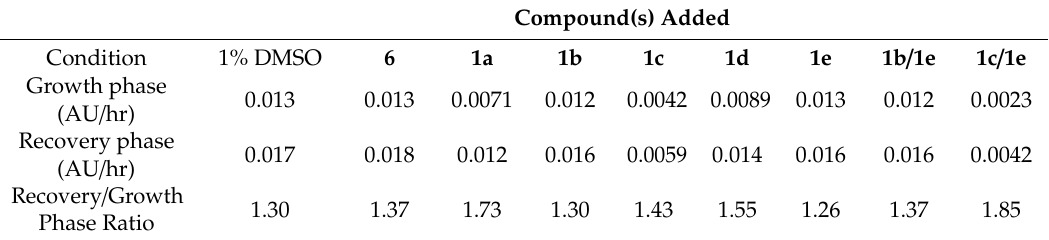
Figure 4. MTT values at 24 h intervals post addition of a single dose of a polycyclic ether-benzopyran. The compounds (30 µM) were added directly after first reading. Arrow indicates time that cells were given fresh medium with no added compound (recovery phase). Values are the mean values from n = 4 replicates. Table 2. Slopes of growth phase curve (0–72 h) and recovery phase curve (96–144 h). Compound(s) Added